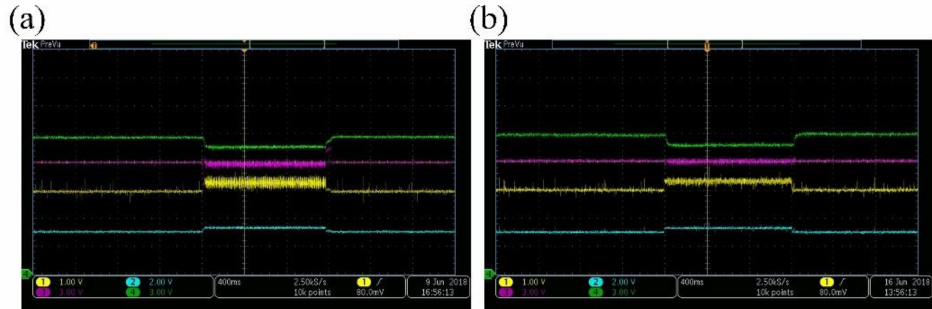
Figure 11. Disturbance change when applying load step: ( a ) voltage control by adaptive backstepping SMC; ( b ) voltage control by